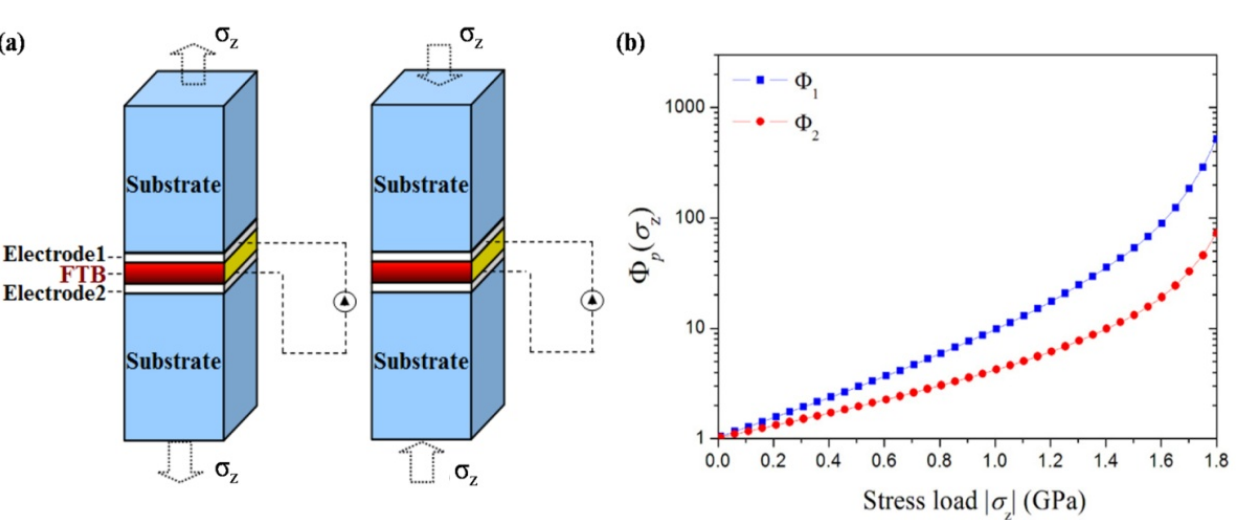
Figure 16. ( a ) Schematic structures of FTJ with applied tensile and compressive stress loads; ( b ) Stress dependence of the giant piezoelectric resistance (GPR) ratio Φ p ( σ z ). (From the work of Zheng et al.